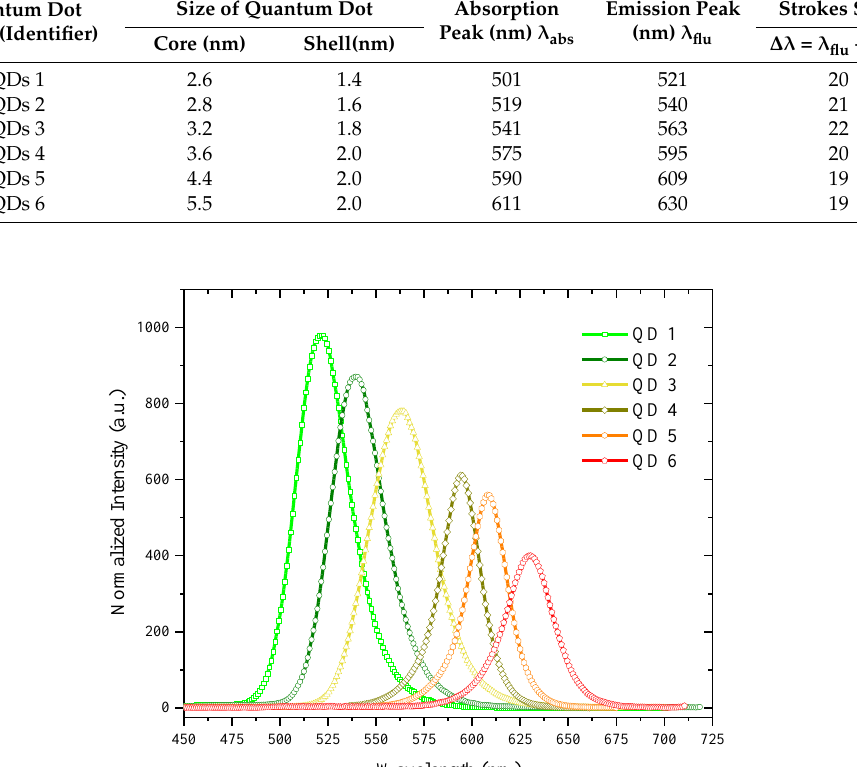
Figure 2. The photoluminescence (PL) for the different sized quantum dots at a concentration of 2 mg in 5 mL of THF.